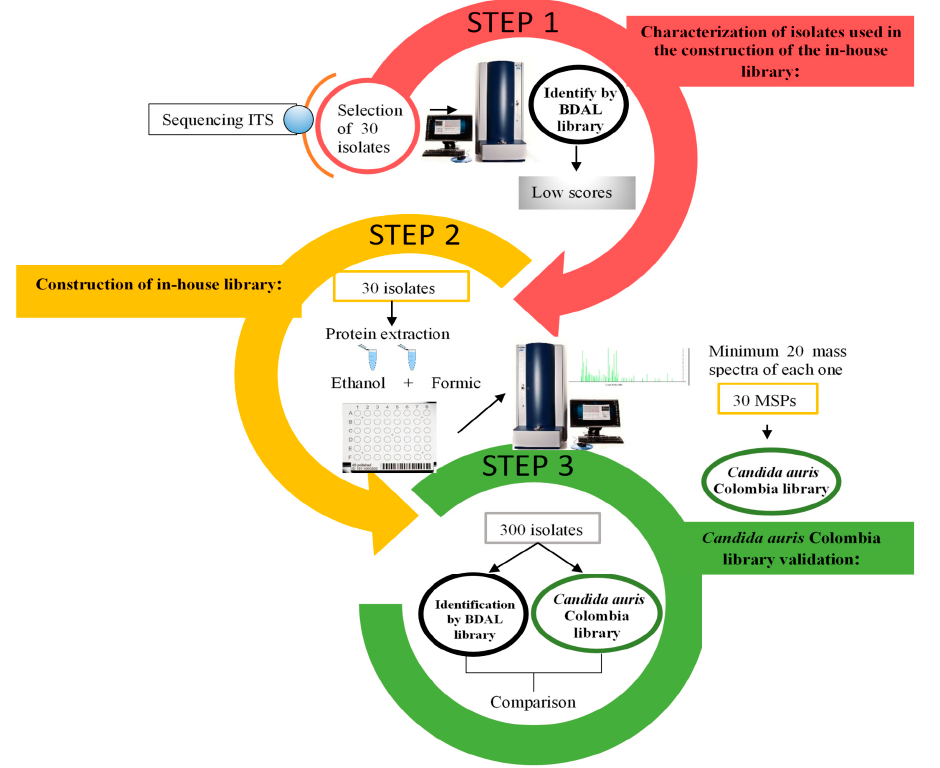
Figure 1. Flowchart methodology of the library construction and validation.